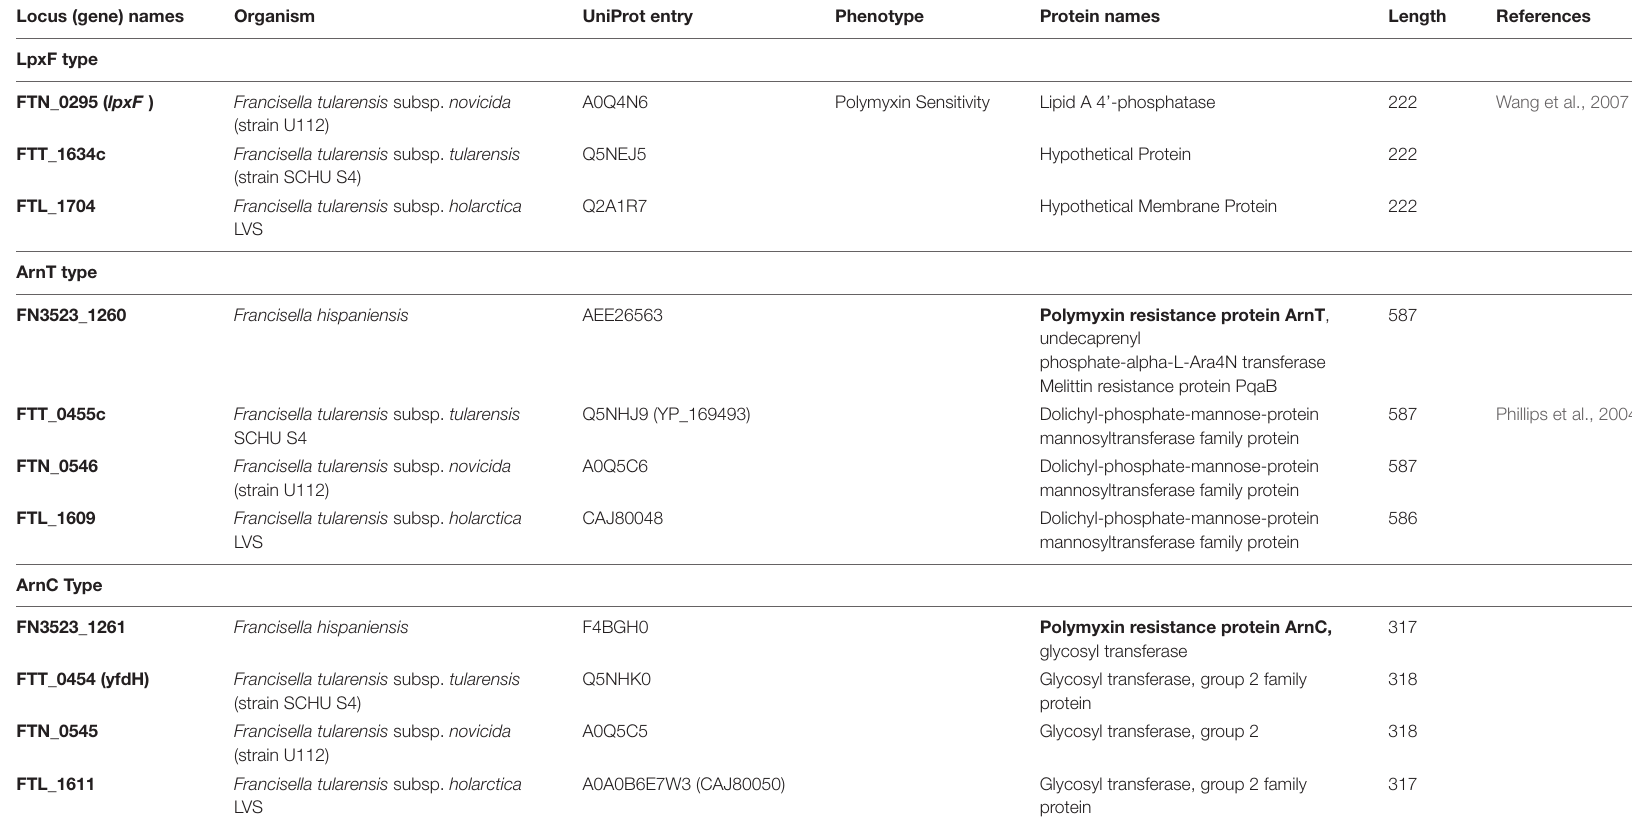
TABLE 6 | Putative polymyxin resistance genes in Francisella (selected data from Uniprot.org and Kegg.jp). Locus (gene)